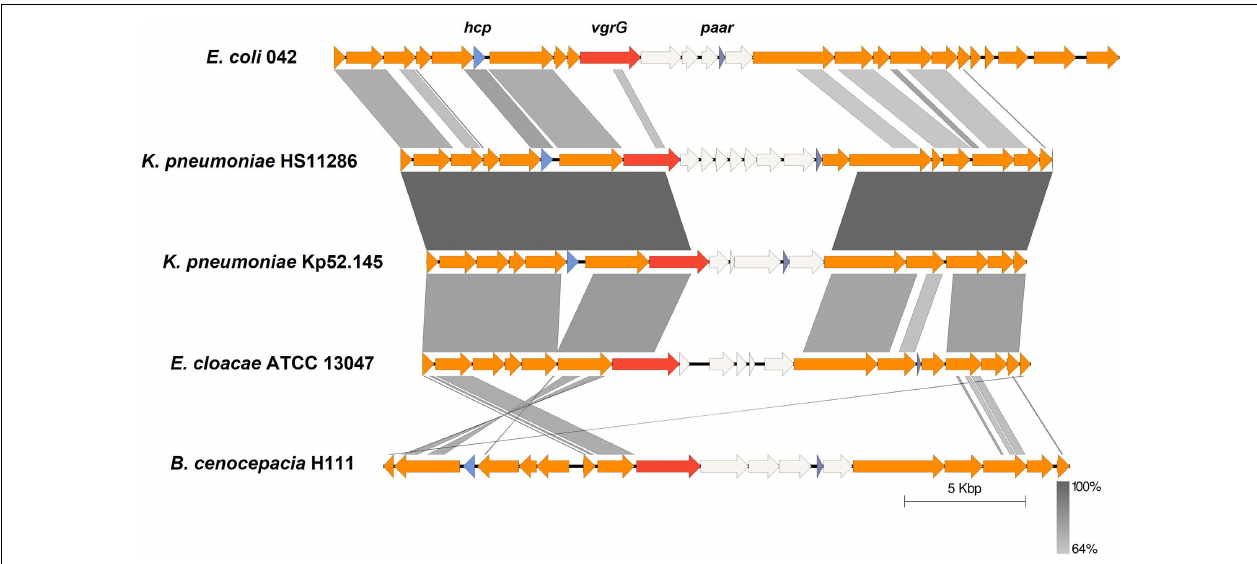
FIGURE 3 | Comparative analysis of genome regions encoding T6SS of type i2. The genomes of different strains were aligned with BLASTn using Easyfig (e-value 1e-3). T6SS-related genes are represented by colored arrows and the key genes hcp , vgrG , and paar are labeled. Non-T6SS-related genes are white. Synteny regions between the sequences are displayed in gray